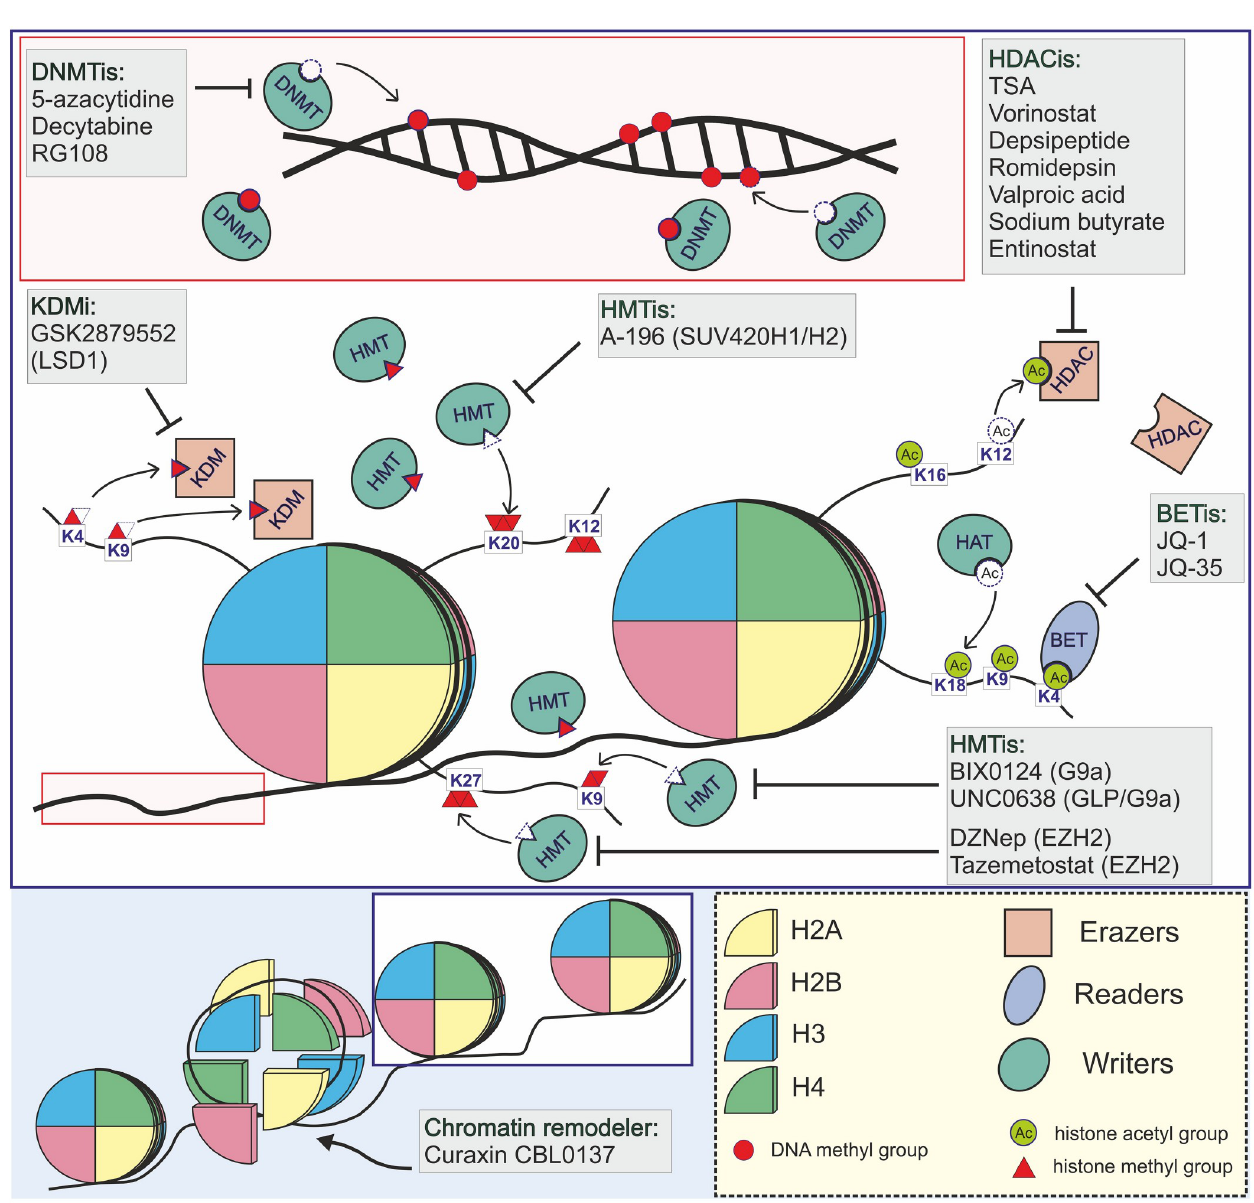
Fig 2. Epigenetic modulators used in the study. HDACis–histone deacetylase inhibitors, DNMTis–DNA-methyltransferase inhibitors, HMTis–histone methyltransferase inhibitors, BETis–bromodomains and extraterminal motif inhibitors, and KDMi–a lysine demethylase inhibitor. inhibitors (HMTis), bromodomains and extraterminal motif inhibitors (BETis), lysine demethylase inhibitors (KDMis) and chromatin remodelers (Fig 2). The group of HDAC inhibitors included agents targeting both individual enzymes of the HDAC class and with pan- activity against vorinostat, valproic acid, sodium butyrate, depsipeptide, pomiferin, and enti- nostat. The group of DNMT inhibitors included the following compounds: 5-azacytidine, dec- itabine and RG108. The group of inhibitors of histone methyltransferases included agents BIX01294, UNC0638, DZNep, tazemetostat and A-196, which inhibit enzymes G9a, GLP, EZH2 and SUV420H1/H2, which are critical for the modifications H3K9me2, H3K27me3 and